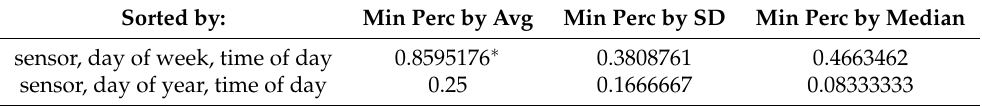
Table 5. Thresholds used for classifying windows by percentile score in phase 1. * indicates the largest threshold, τ 1